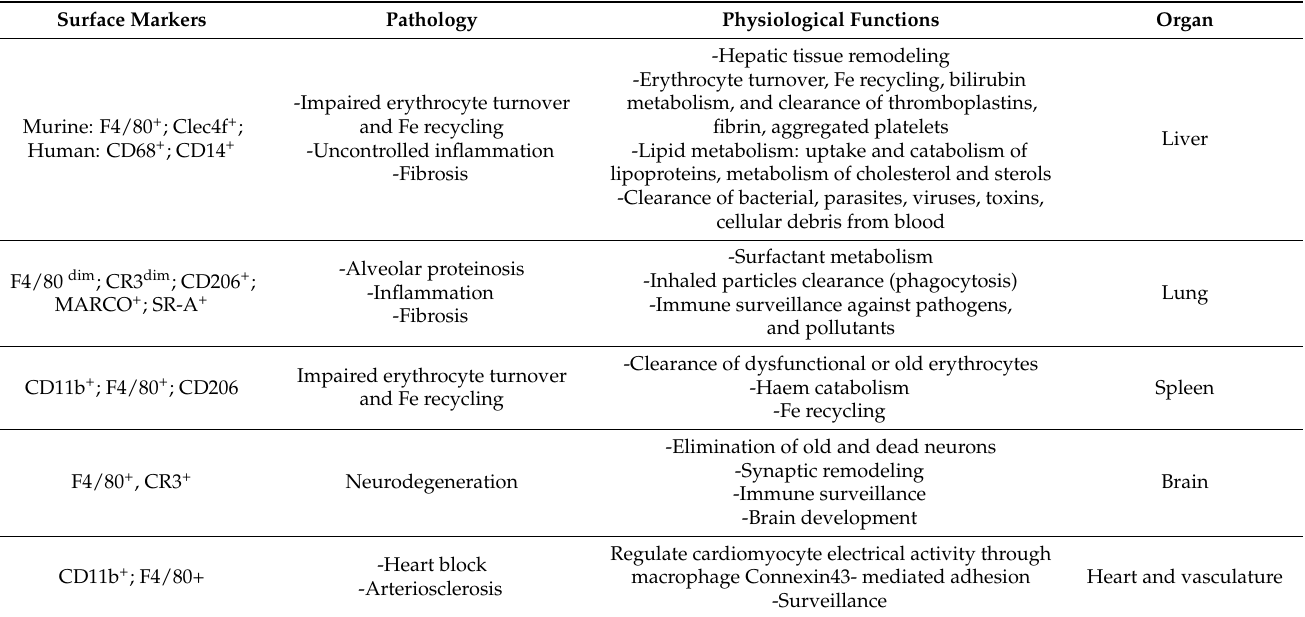
Table 1. Different phenotypes and functions of resident macrophages in the main organs of the